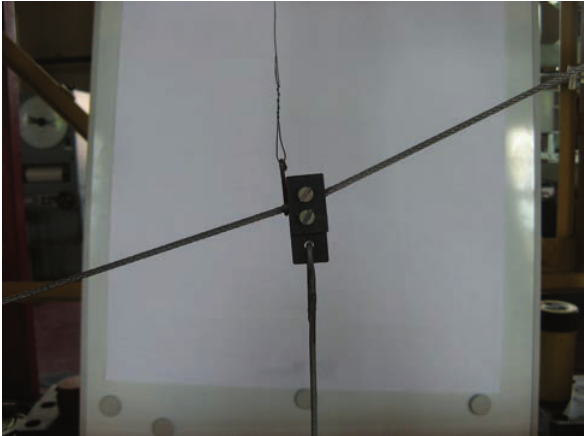
Fig. 7. Nodal point of the cable where the vertical displacements were measured